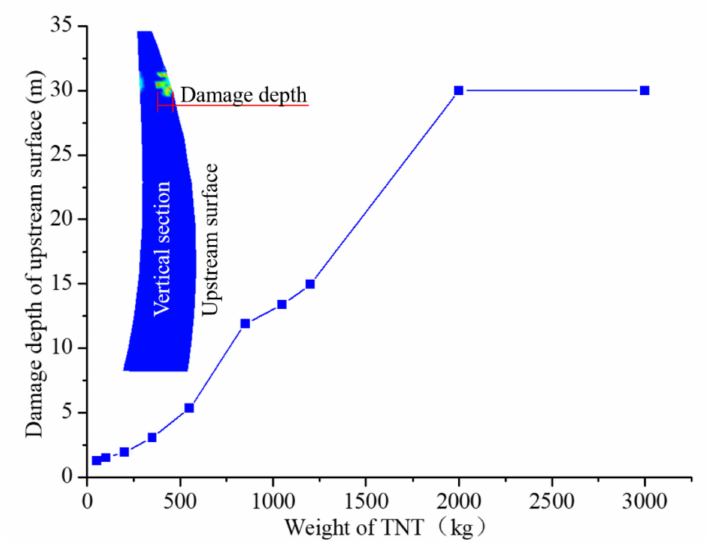
Figure 6. Damage extension depth of the upstream surface of the arch